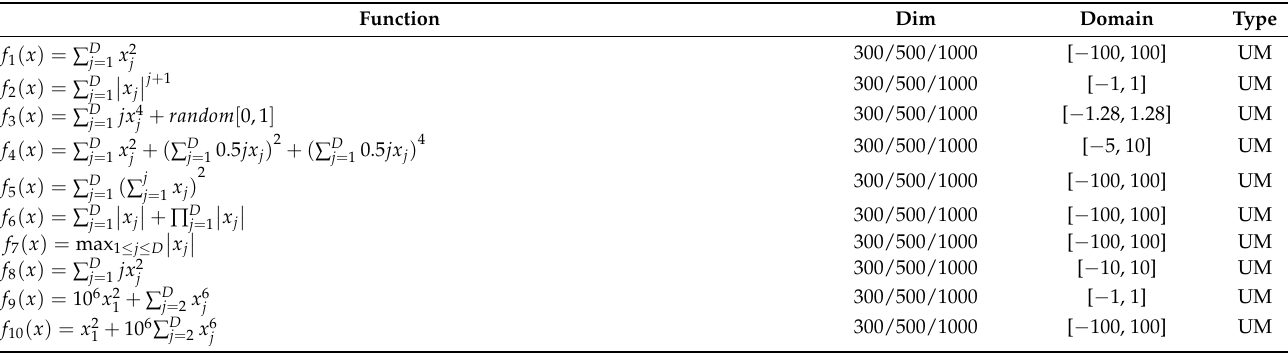
Table 1. Description of benchmark test